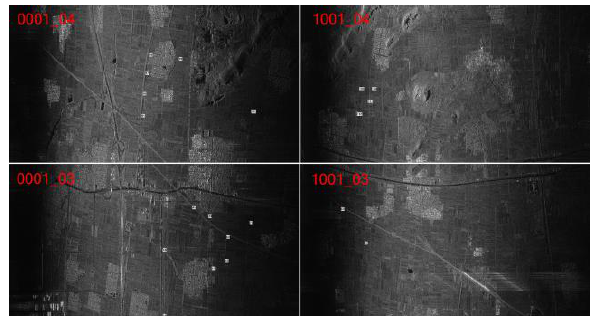
Fig.8 GCPs’ Distribution for Data 0001_04, Data 0001_03, Data 1001_04 and Data